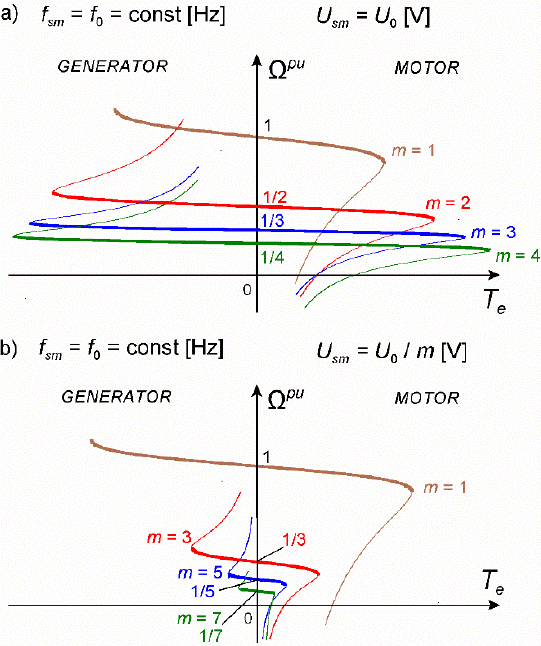
Figure 2. Typical mechanical characteristics of multiphase induction motors at given supply se- quences m : ( a ) motors with the first type of stator winding; ( b ) motors with the second type of stator winding.